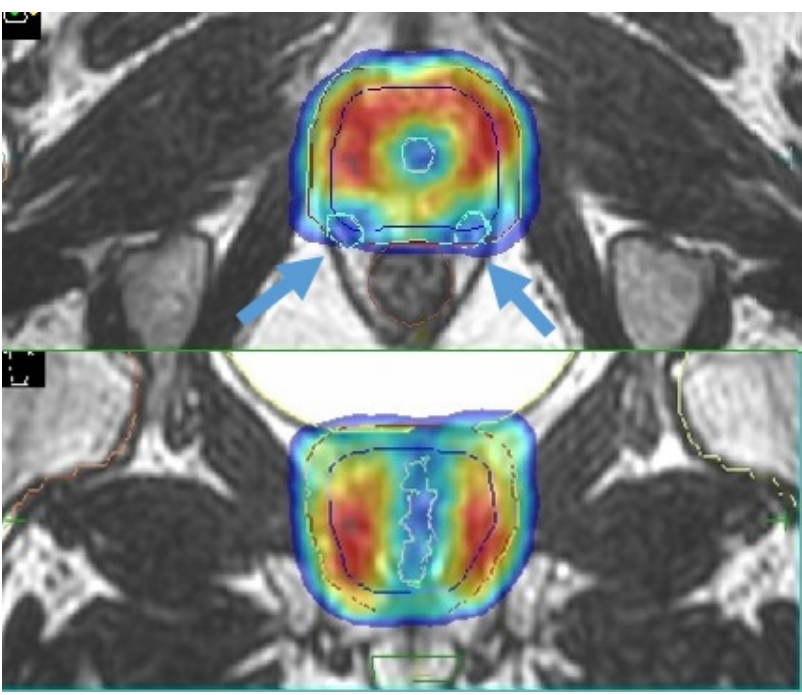
Figure 4. Sexual preservation during MR-guided prostate SBRT (blue arrows indicate the prostate neurovascular plexus).